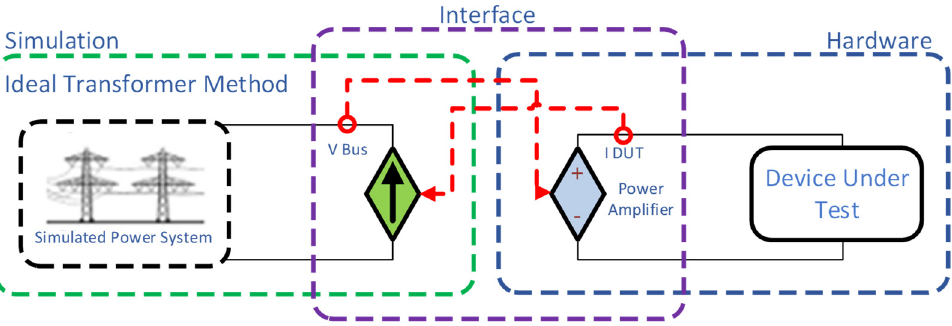
Figure 9. Example of ideal transformer model (ITM) between the RTS and the hardware.